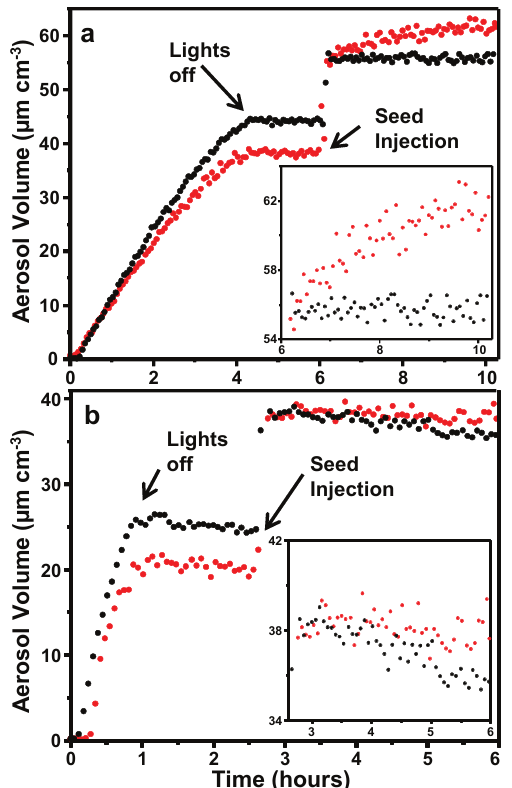
Fig. 7. Time traces of aerosol volume as a result of SOA growth from OH oxidation of α -pinene followed by injection of ammo- nium sulfate seed (black) or ammonium sulfate and sulfuric acid seed (red) under (a) low-NO x and (b) high-NO x (methyl nitrite pho- tolysis) conditions. The difference in the quantity of self-nucleated aerosol volume growth from both (a) low- and (b) high-NO x ex- periments is due to greater gas-phase α -pinene concentration at the beginning of each of the AS seed experiments compared to the AS+SA experiments.